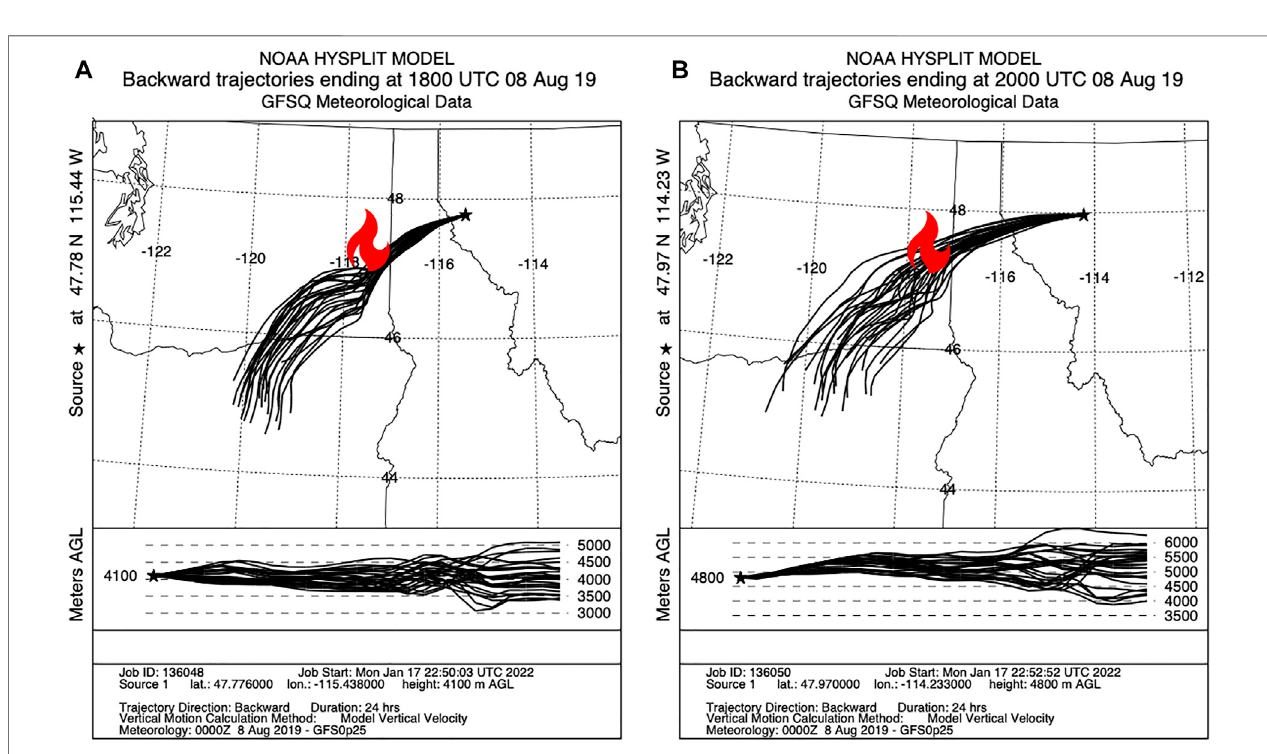
FIGURE3| NOAA HYSPLIT ensemble back trajectories fromthe median smoke plume thickness beginning at 18:00UTC [ (A) ;left] and 20:00UTC [ (B) ;right] on8 August 2019. The location of the Williams Flats Fire is indicated (red fl ame) in the source region of the smoke plumes sensed by CPL.